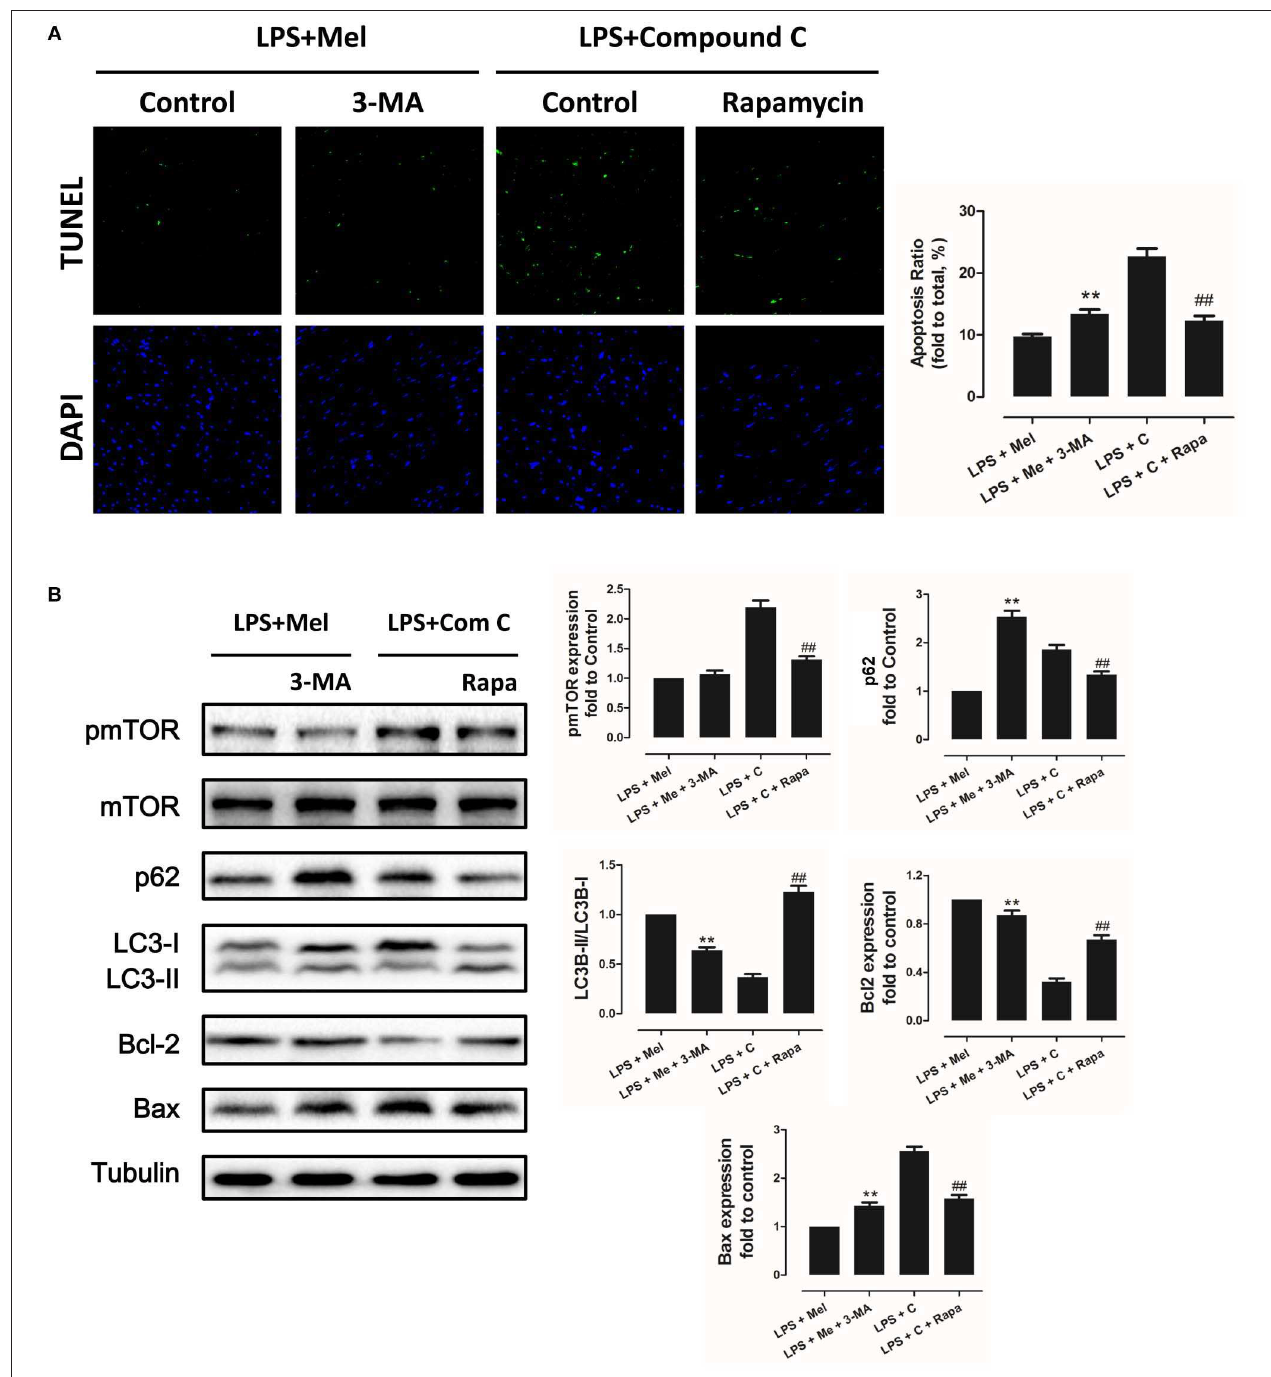
FIGURE 8 | Autophagy inhibition increased myocardial apoptosis, and autophagy activation decreased Compound C induced myocardial apoptosis. (A) Representative images of TUNEL staining and quantitative analysis of the apoptosis ratio. (B) Representative bands of western blot and quantitative analysis of pmTOR phosphorylation levels, p62 expression, LC3B-II/LC3B-I ratio, Bcl-2 expression and Bax expression. n = 6, ** P < 0.05 vs. the LPS + melatonin group, ## P < 0.05 vs. the LPS + Compound C group. Mel, melatonin; C, Compound C; Rapa, rapamycin.